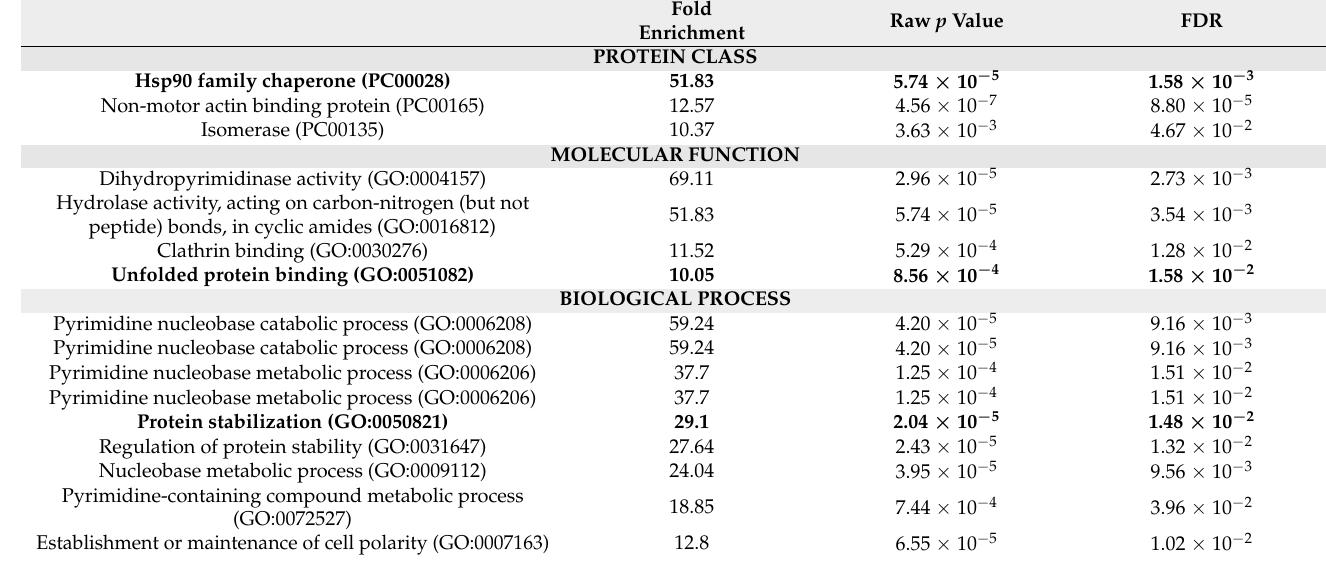
Table 1. Gene Ontology analysis